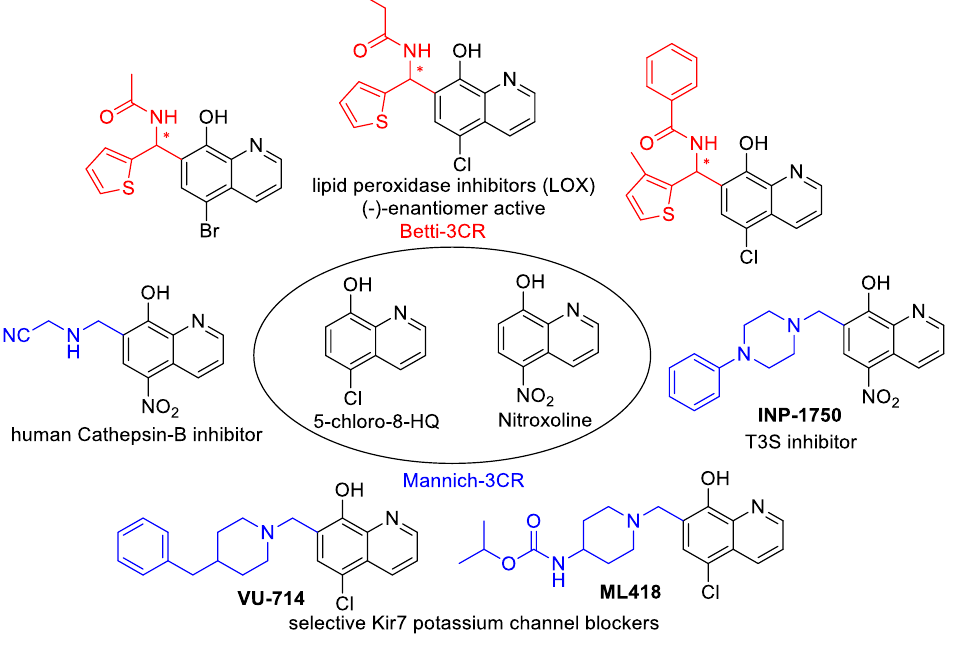
Figure 1. Cytotoxic 8-hydroxyquinoline (8-HQ) analogues.